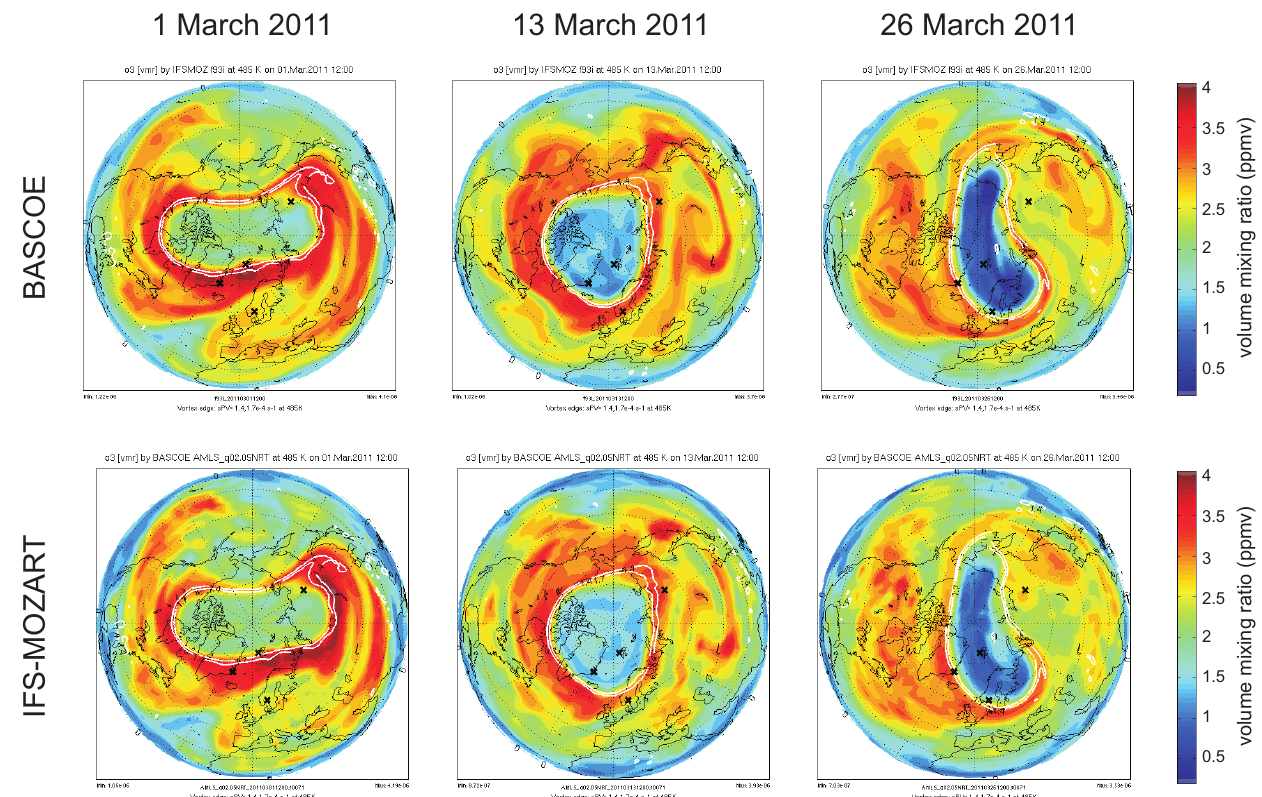
Figure 8. Evolution of ozone volume mixing ratios at 485K ( ∼ 20km, ∼ 50hPa) during March 2011 (left: 1 March, middle: 13 March, right: 26 March). Red/blue colours indicate respectively high/low ozone values. In white, the inner and outer polar vortex edges are indicated, calculated with an sPV of, respectively, > 1 . 7e − 4 s − 1 and > 1 . 4e − 4 s − 1 . Top: IFS-MOZART, bottom: BASCOE. The location of three SAOZ stations used for the detailed total ozone column evaluation are indicated by black crosses: Zhigansk (Russia, 66.8 ◦ N, 123.4 ◦ E); Harestua (Norway, 60 ◦ N, 11 ◦ E); Scoresby Sund (Greenland, 70.49 ◦ N, 21.98 ◦ W); as well as the location of the O 3 sonde at Ny-Ålesund (Spitsbergen, 78.933 ◦ N, 11.883 ◦